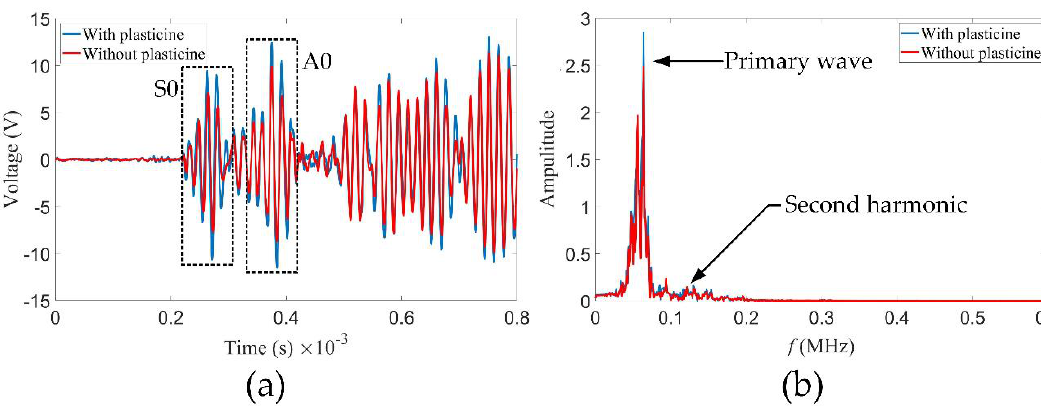
Figure 14. ( a ) Time domain signals when the plasticine is on the vector of an i–j pair. The signals of the aluminum plate without plasticine are shown as blue lines, and the ones of the aluminum plate with plasticine are shown as red lines. ( b ) Frequency spectrum corresponding to ( a ). The central frequency of the excitation signal is 60 kHz.